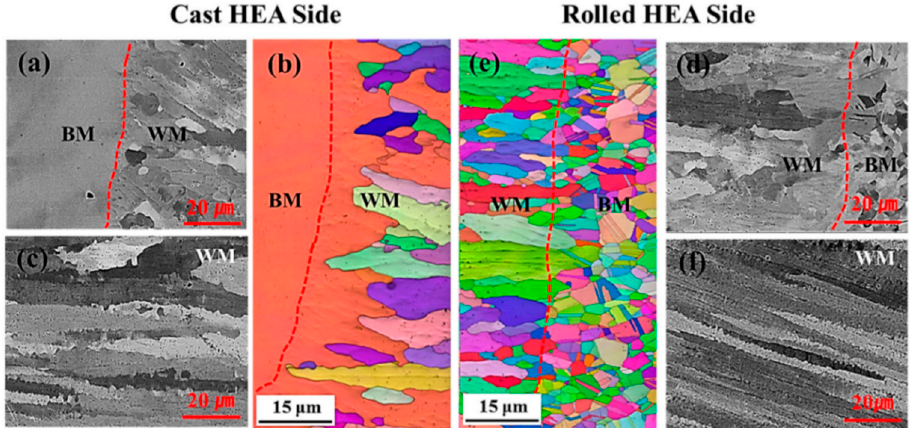
Figure 5. Microstructure of the dissimilar welds: ( a , b ) Dendritic growth nucleated from the fusion boundary on the cast HEA (high entropy alloy) side; ( c ) dendrites from near the centerline on the cast WM side; ( d , e ) dendritic growth nucleated from the fusion boundary on the rolled HEA side; ( f ) Dendrites from near the centerline on the rolled WM side. BM—Base material; WM—Weld metal (Reproduced from [57], with permission from Taylor & Francis,